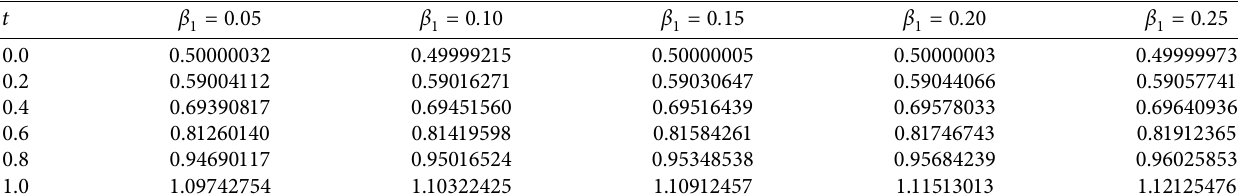
Table 14: Approximate solutions obtained by the LeNN-WOA-NM algorithm for population density of the predator Y ( t ) under the influence of β 1